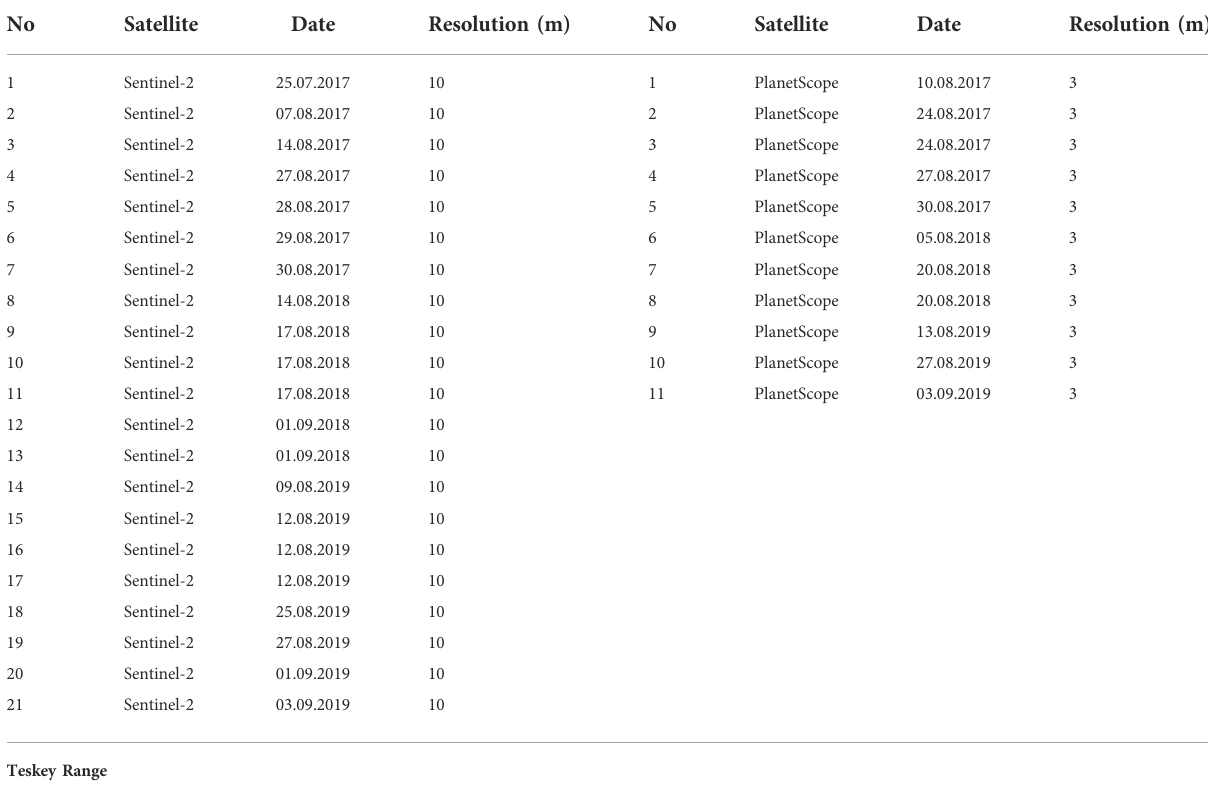
TABLE 1 List of satellite images used for